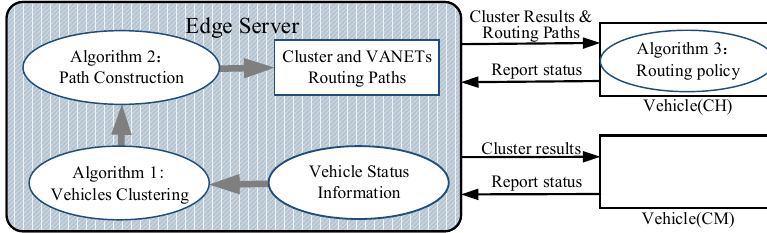
Figure 2. Basic operation logic of the three core algorithms in